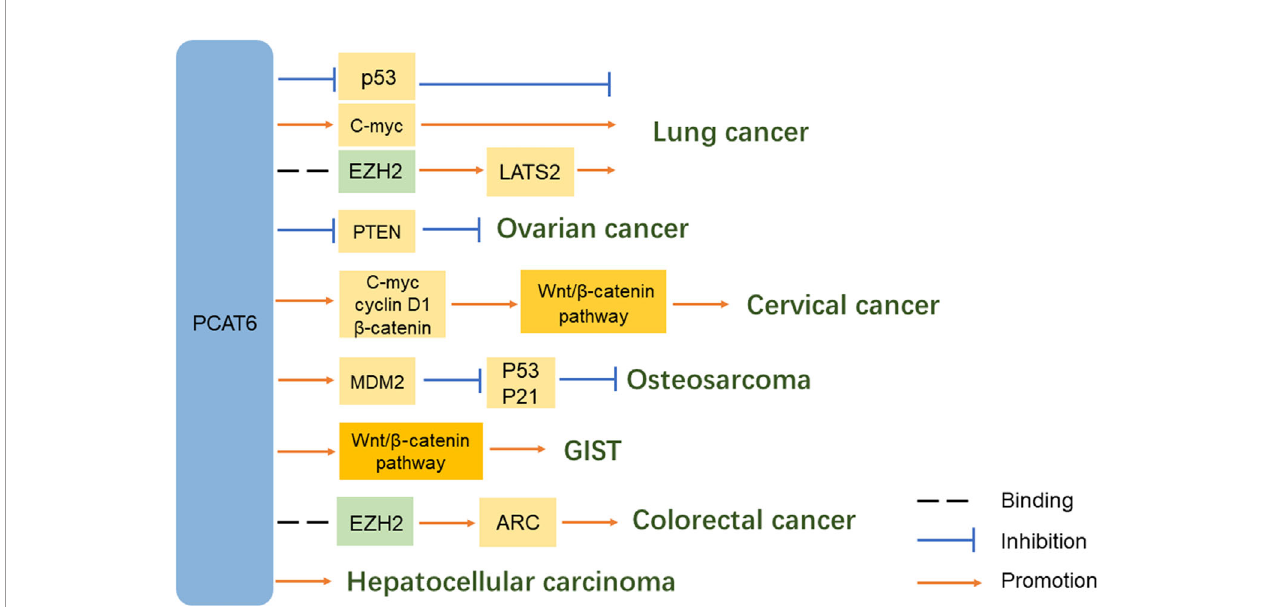
FIGURE 3 | Role of lncRNA PCAT6 in carcinogenic signaling pathways.